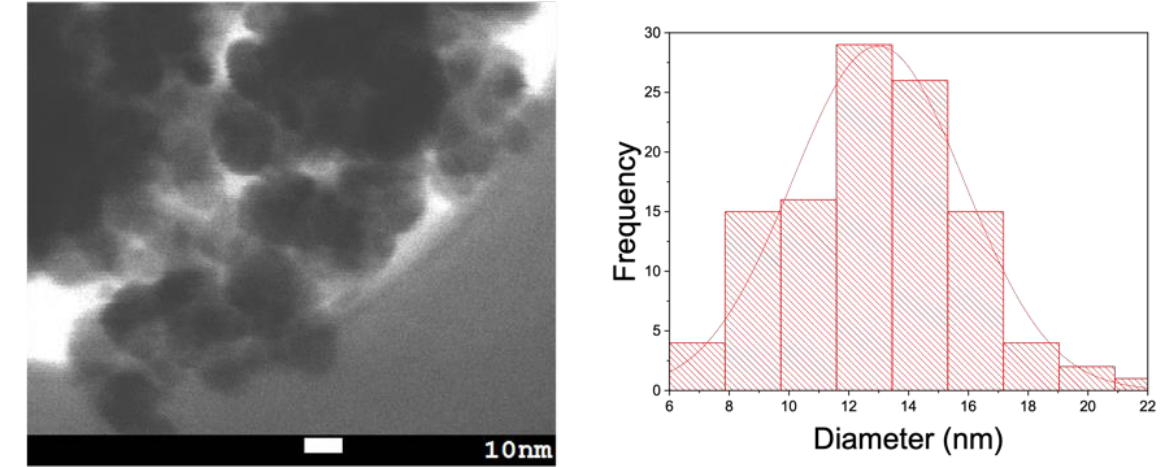
Figure 2. Microscopy image of uncoated Fe 3 O 4 with the corresponding histogram. The synthesis of Fe 3 O 4 was also corroborated by infrared (IR) spectroscopy (Figure 3, black spectrum). From the assignment of the absorption bands observed in the IR spectra obtained, it was possible to analyze the respective functional groups of the molecules present in each of the synthesized materials. Thus, a broad band centered at 3252 cm − 1 , corresponding to the overlapping valence vibrations of the N–H and O–H bonds, was observed. It was assigned to NH 4+ and OH − ions and adsorbed water molecules on the surface of MNPs. In addition, the band at 1628 cm − 1 can be attributed to the bending of the NH 4+ group on the magnetite surface. Finally, at 573 cm − 1 , a band assigned to the valence vibration of the Fe–O bond of Fe 3 O 4 was observed.